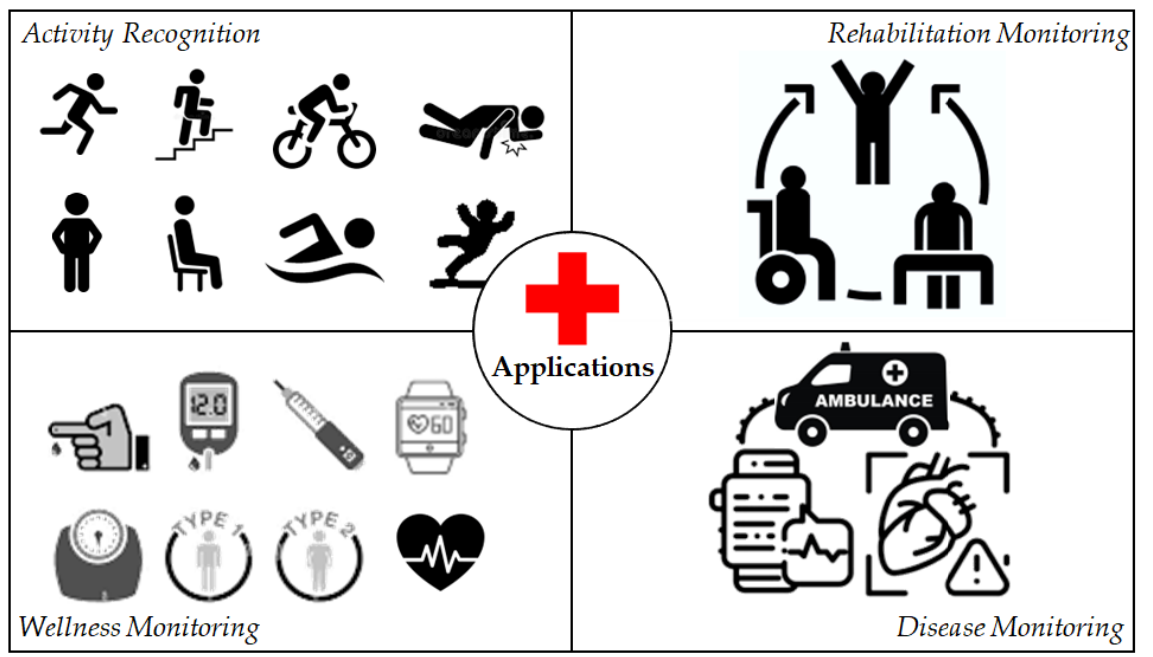
Figure 1. Some applications of pervasive computing in the healthcare Internet of Things. Section 3 reviews these components in detail.